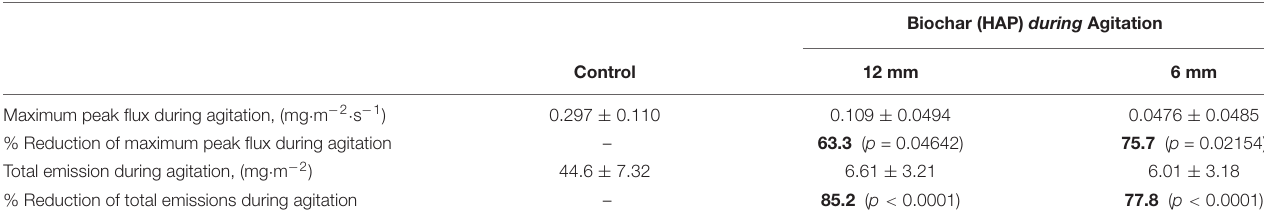
Biochar (HAP) during